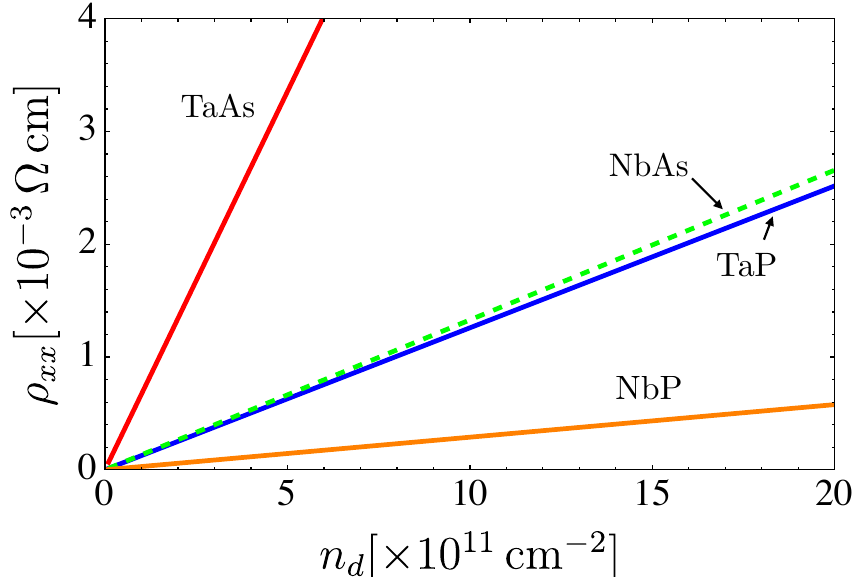
Figure 11. Total resistance, R = 1/ G , as a function of the concentration of defects n d for the family of materials TaAs, TaP, NbAs and NbP. The graphs were computed at zero